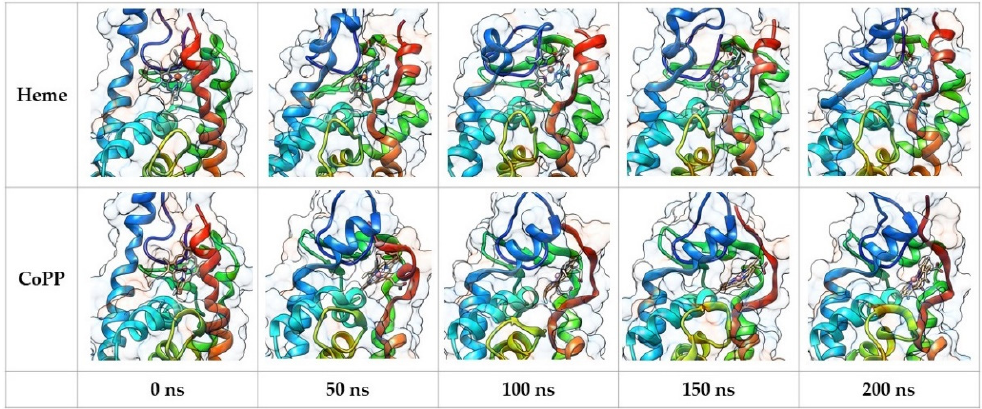
Figure 6. Snapshot of the molecular dynamic simulation trajectories of CoPP and Heme against Agonist-REV-ERB β .